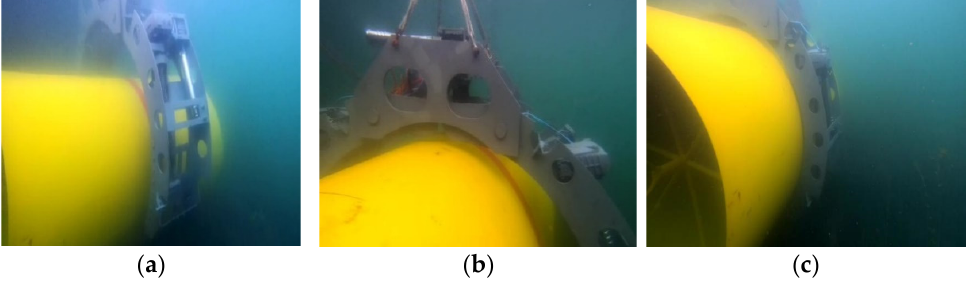
Figure 16. Clamping test of the manipulator: ( a ) Close to the object, ( b ) Posture adjustment and ( c ) Hold the object.